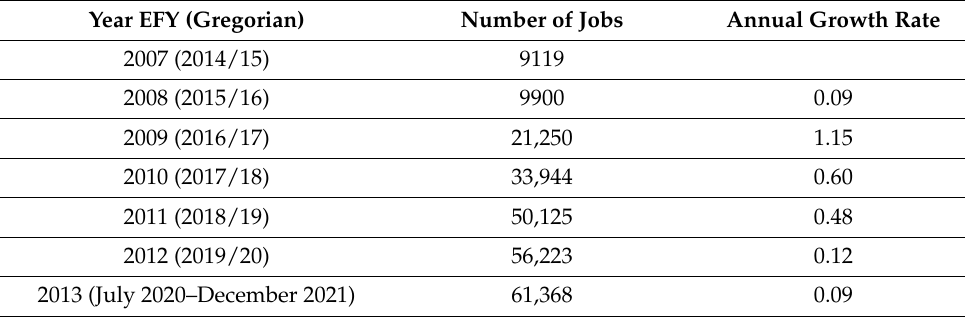
Figure 7. IPDC-owned IPs’ annual export growth rate (2014/15–2020/21); Source: IPDC, computed by authors; 2021.